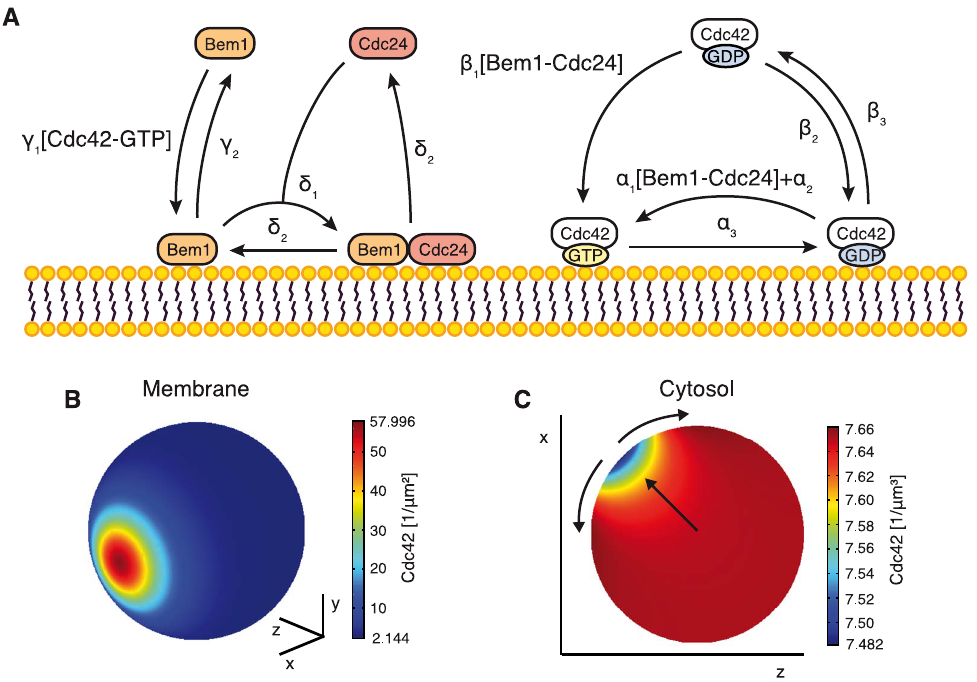
Figure 1. Details of the mechanistic model for GDI-mediated cell polarization in yeast. A Schematic representation of model reactions. A list of all model reactions is given in the Materials and Methods section. B Numerically obtained polarized Cdc42 distribution on the membrane for control conditions. C Corresponding cytosolic distribution of Cdc42 in the x-z plane. Arrows indicate protein flux.